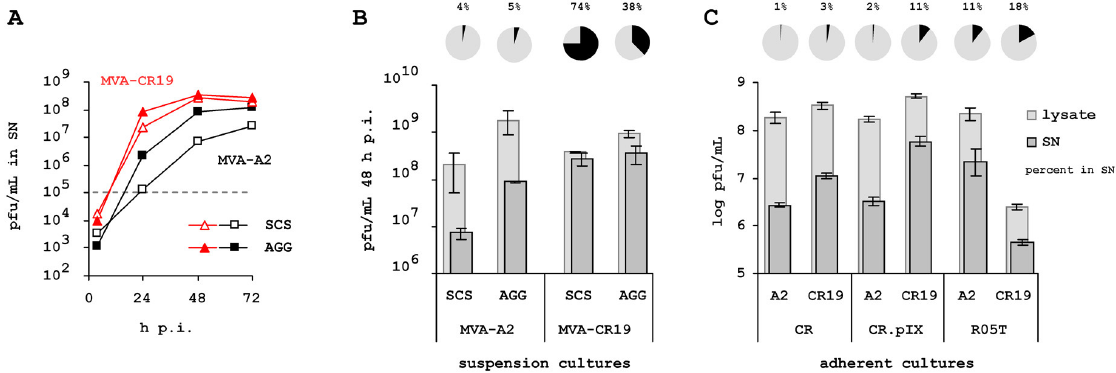
Figure 4. Fraction of infectious units in the supernatant of cells in suspension and adherent cultures. ( A ) Kinetic of replication of isolates MVA-A2 and MVA-CR19 in CR.pIX suspension cultures with (bold symbols) or without (open symbols) induction of cell aggregates that promote replication of various hyperattenuated poxviruses